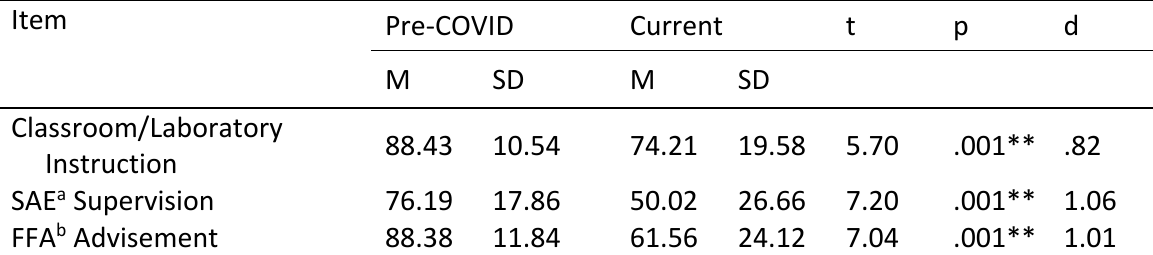
Self-Efficacy of School-based Agricultural Education (SBAE) Teachers in South Carolina Prior to and During the COVID-19 Pandemic (n = 72) Item